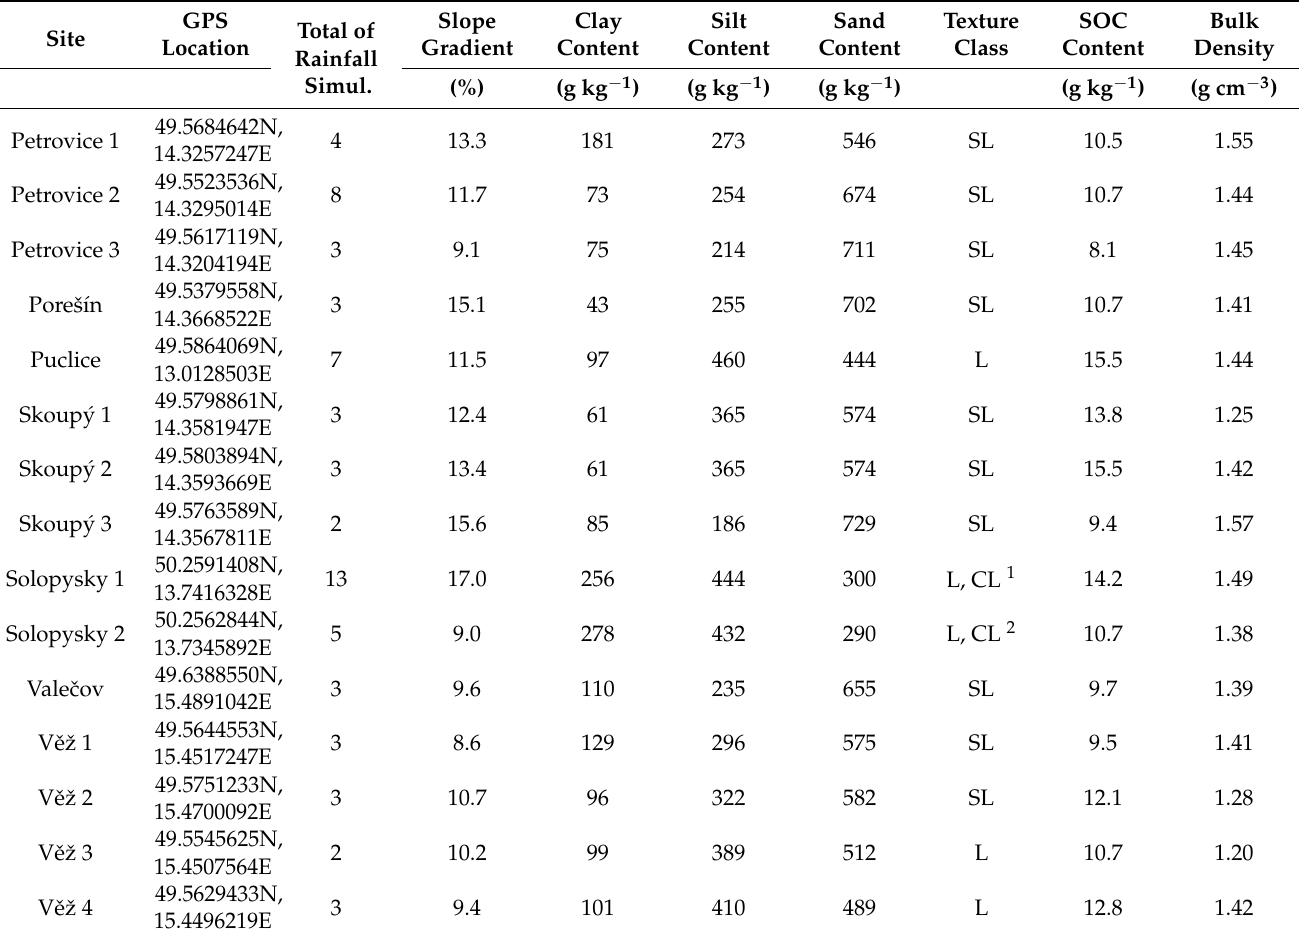
The rainfall simulator (Figure 2) had four sprinklers with an adjusted water pressure of 50 kPa. The rainfall intensity was set to about 1 mm min − 1 , which corresponds to the average heavy rainfall intensity in the Czech Republic [37]. The average raindrop diameter accounted for 1.5 mm to 2.0 mm and the average kinetic energy of the raindrops